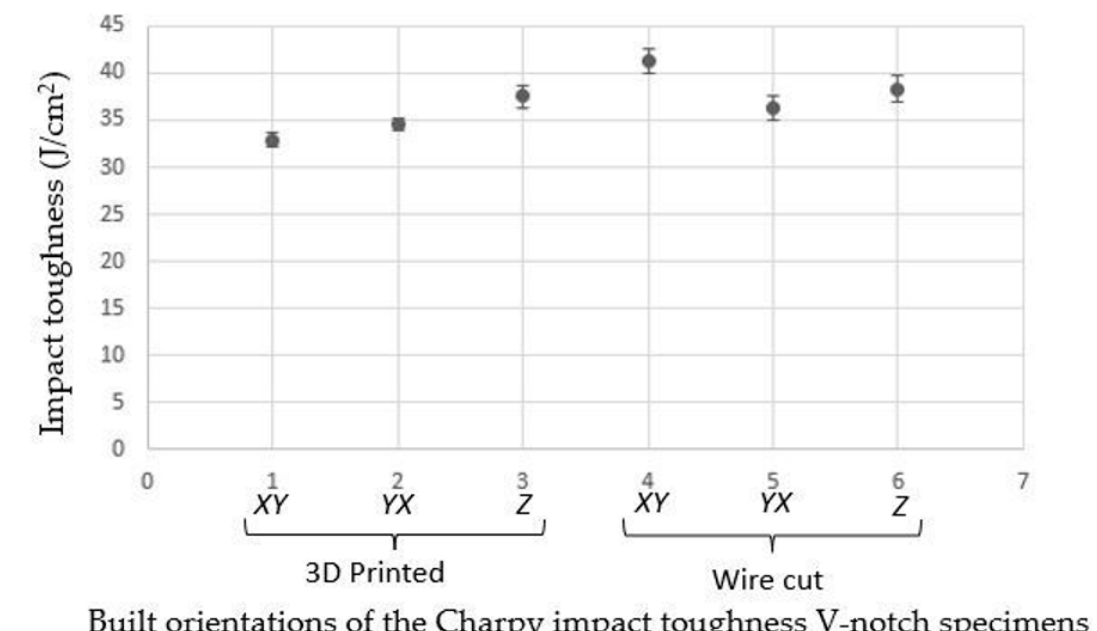
Figure 3. An illustration of the impact toughness dispersion concerning the built orientations of the 3D print and wire-cut V-notch specimens.